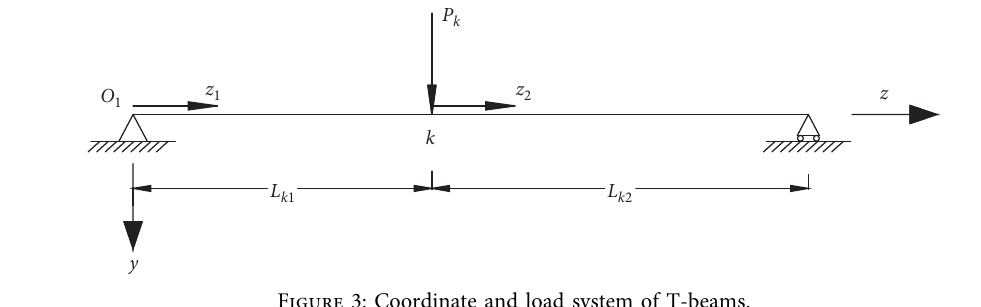
Figure 3: Coordinate and load system of T-beams.